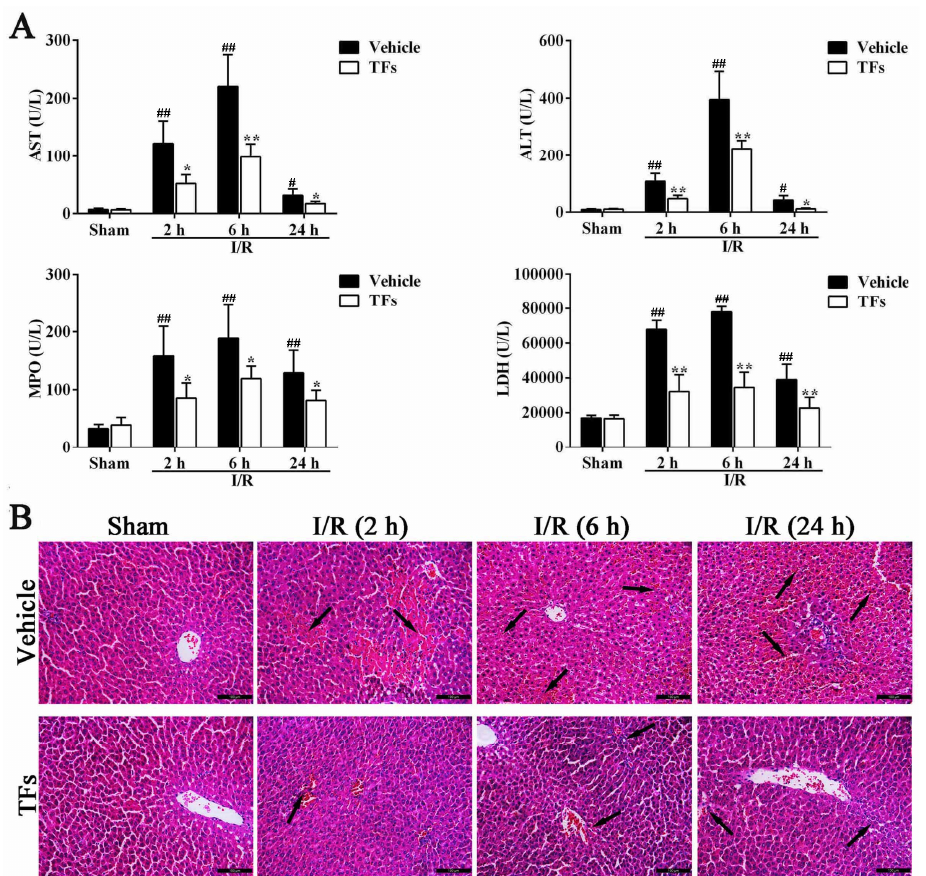
Figure 1. TFs reduced AST, ALT, MPO, and LDH activities after I/R injury. ( A ) Effects of TFs on serum AST, ALT, MPO, and LDH activities after 1 h of ischemia and different times of reperfusion (2 h, 6 h, and 24 h). Data are presented as the mean ˘ SD ( n = 6). # p < 0.05 and ## p < 0.01 versus sham; * p < 0.05 and 24 h). Data are presented as the mean ± SD ( n = 6). # p < 0.05 and ## p < 0.01 versus sham; * p < 0.05 and ** p < 0.01 versus vehicle; and ( B ) effects of TFs on HE staining (200 ˆ magnification) after 1 h of and ** p < 0.01 versus vehicle; and ( B ) effects of TFs on HE staining (200× magnification) after 1 h of ischemia and different times of reperfusion (2 h, 6 h, and 24 ischemia and different times of reperfusion (2 h, 6 h, and 24 h).